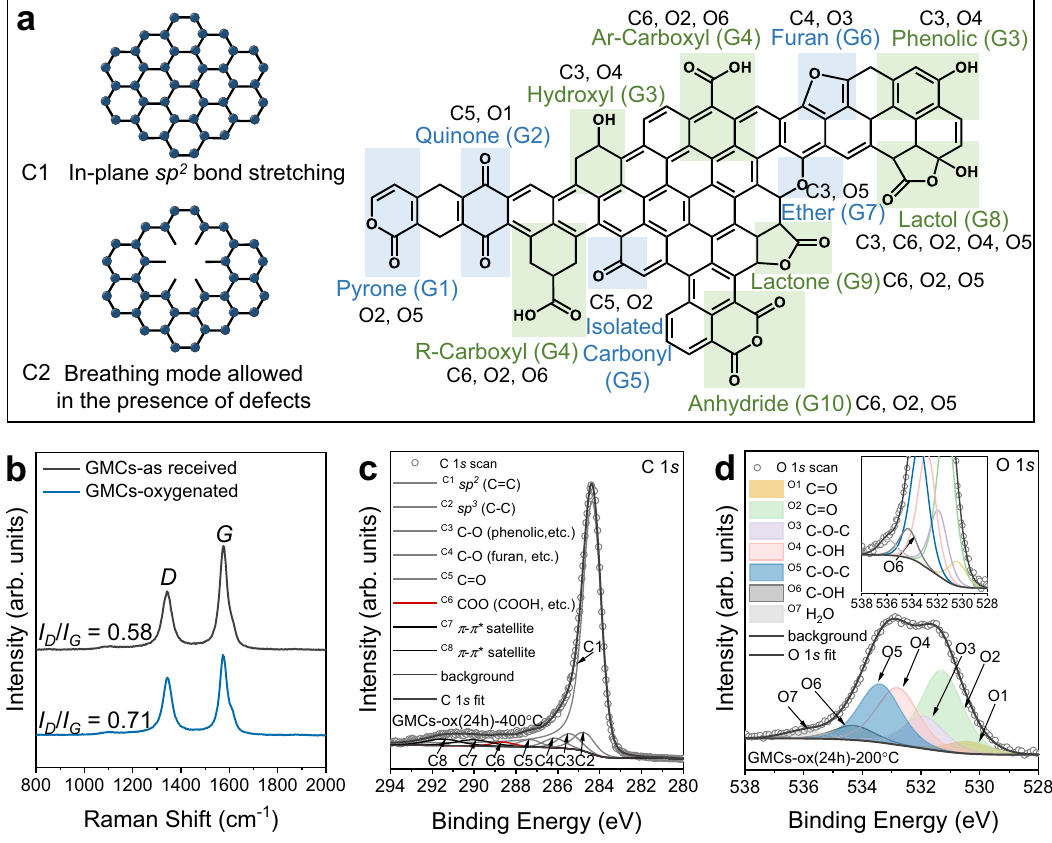
Fig. 1 | Carbon surface microenvironment. a Graphitic model structures and oxygen-containing functional groups (OCFGs): green and blue shadings indicate acidic and basic OCFGs, respectively. b Raman spectra of as-received GMC and GMC-ox(oxygen-functionalized)normalizedtothe D -bandintensityoftheGMC-as